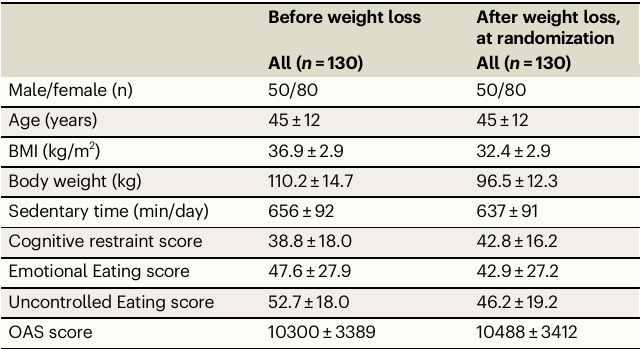
Table 1 | Characteristics of participants before and after the low-calorie